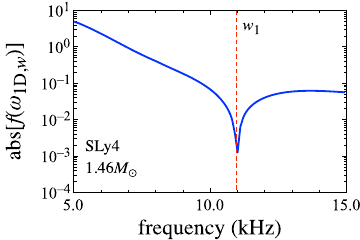
frequency for the neutron star model with 1 . 46 M (cid:2) constructed with SLy4 EOS, where the vertical dashed line denotes the w 1 -mode fre- quency determined though the proper eigenvalue problem without the approximation